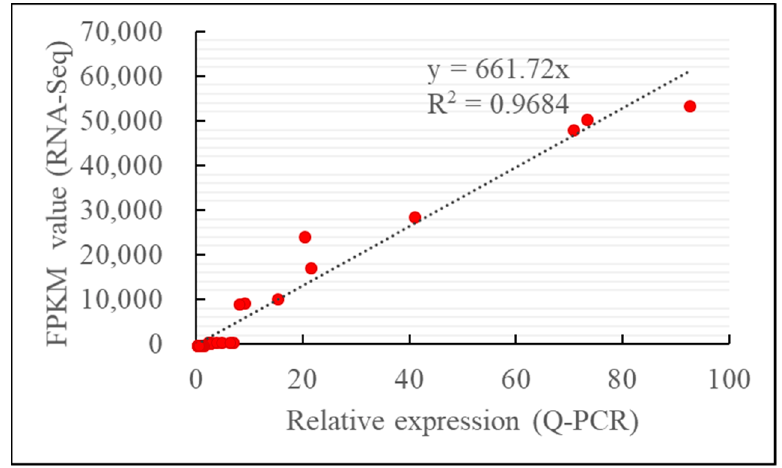
Figure 5. The correlation analysis of gene expression value from quantitative real-time PCR (Q-PCR) and RNA-Seq.